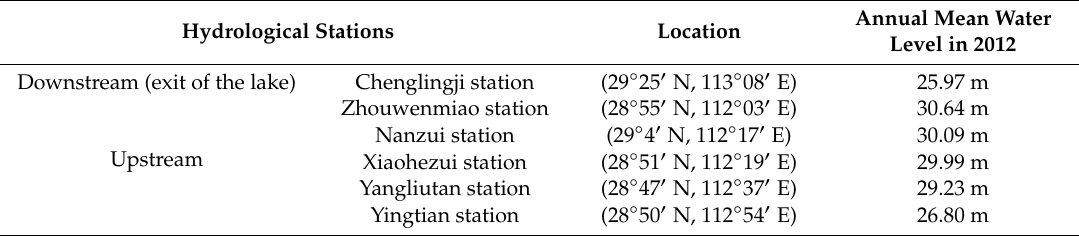
Table 1. Hydrological station information of Dongting